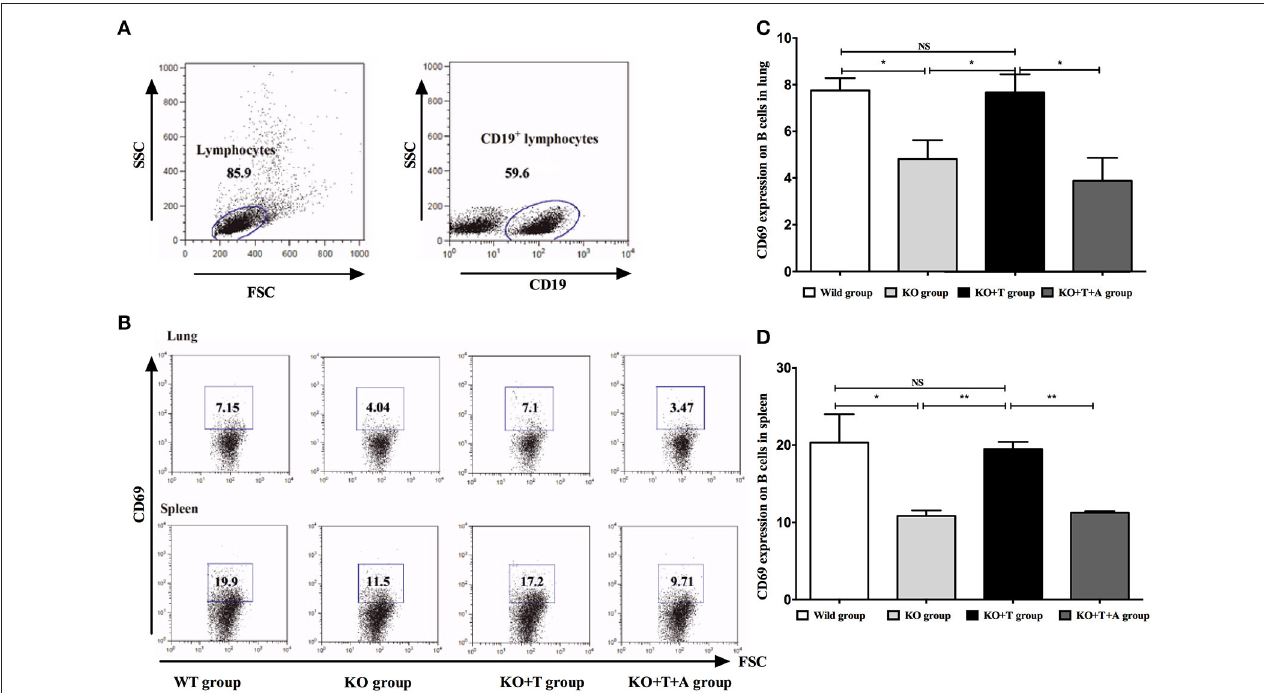
FIGURE 3 | Effect of IL17- γδ T cells on B cells activation. The mice in all groups were processed as described in Figure 2 . On day 7 post infection, CD69 expression in CD19 + B cells from the lung and spleen were measured. (A,B) Representative dot plots of CD69 staining in CD19 + B cells. (C) Percentage of CD19 + B cells in the lung expressing CD69. (D) Percentage of CD19 + B cells in the spleen expressing CD69. * p < 0.05, ** p < 0.01. These results represent three independent experiments.